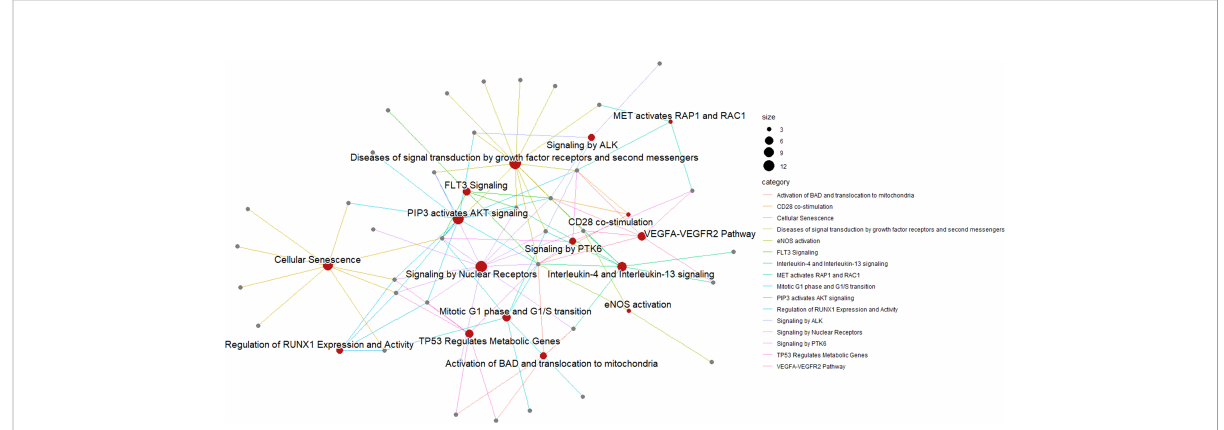
FIGURE 4 Pathway enrichment analysis of M(0) THP-1 macrophage-like treated with sEV PBDE+LPS . A network represents the result of the pathway enrichment analysis. Here, red nodes are pathways, and grey nodes are genes. Links indicate interaction among pathways and genes; each gene can interact with more than one pathway. As shown on the right of the fi gure, the size of each red node is related to the number of genes contained in the pathway, whereas the color of each link depends on the speci fi c biological pathway.